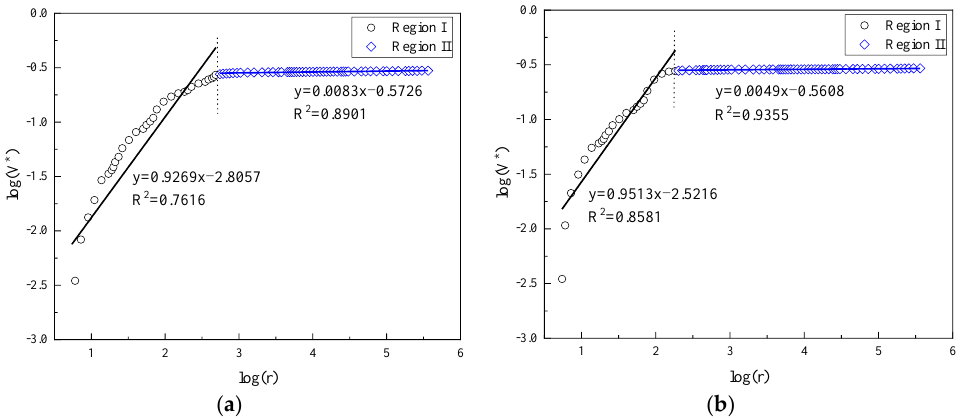
Figure 10. Multifractal characteristics of FCP10 at different ages under Ji’s model. ( a ) 3 days, ( b ) 28 days.